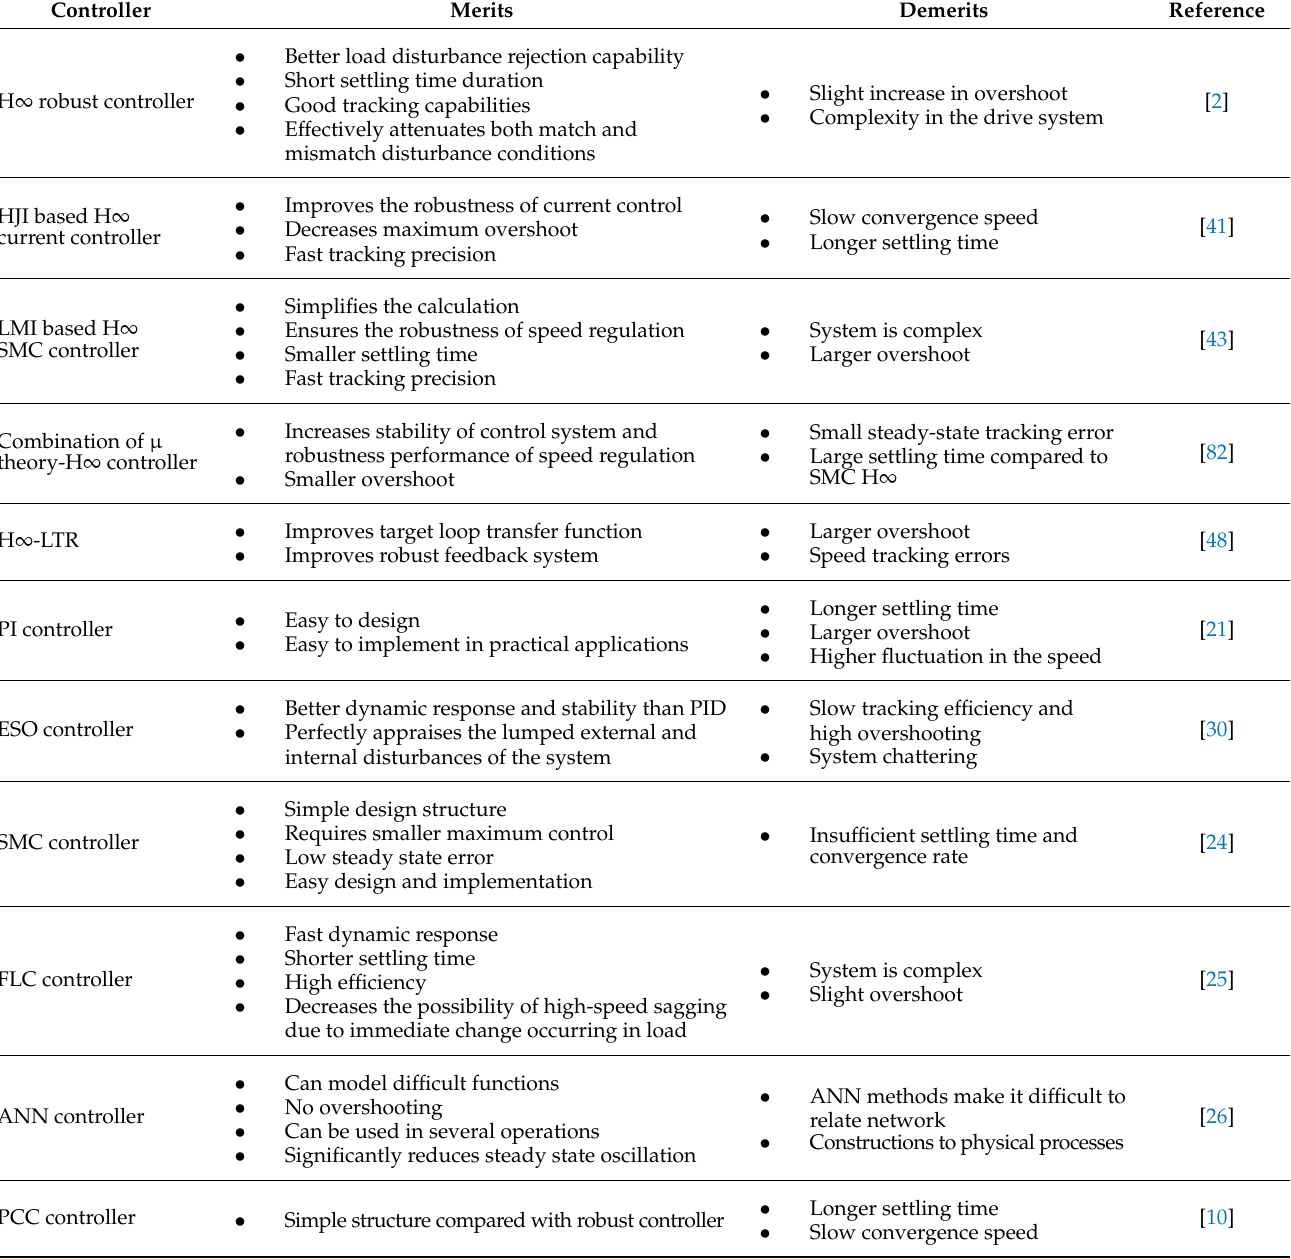
Table 1. Comparative analysis of different speed control techniques used for PMSM speed